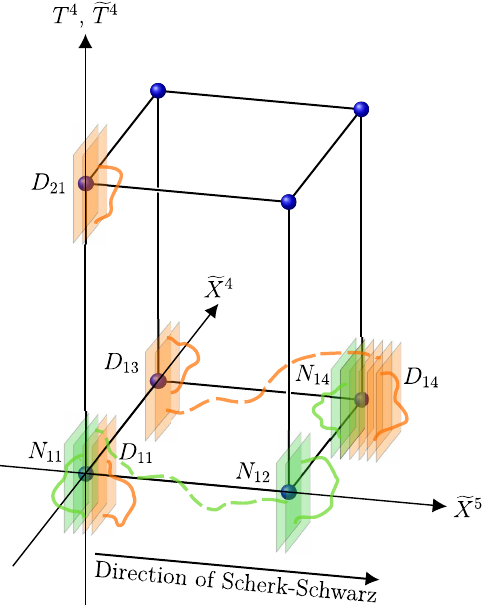
(b) Massless bosonic states in the ND+DN sector are symbolized as strings attached to stacks of D3- branes T-dual to D9-branes and D5-branes that are located at corners having the same coordinates ˜ X 4 and ˜ X 5 . For the massless fermionic states in the ND+DN sector, the corners have same coordinate ˜ X 4 and distinct coordinate ˜ X 5 .